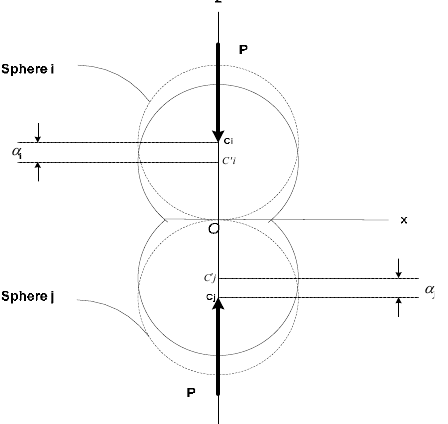
Fig. 2. Two balls contacting with each other and convert kinetic energy to deformation energy during collision of two balls